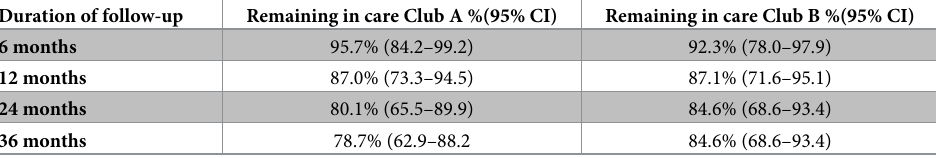
Table 4. Kaplan-Meier estimates of the retention in care behaviours of patients attending two adherence clubs at Facility X.